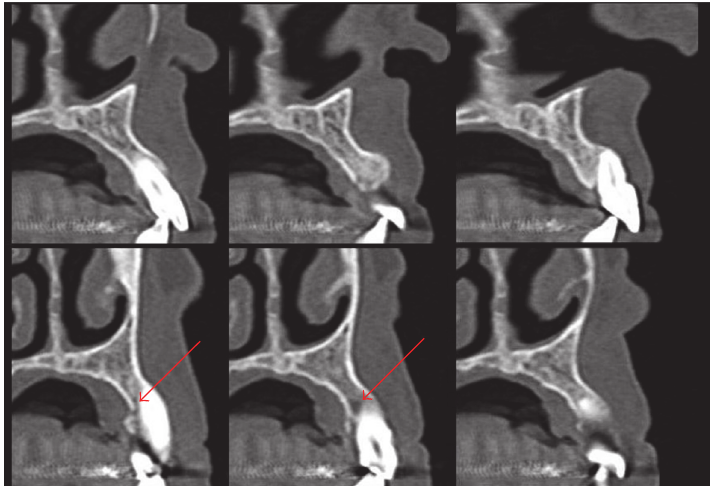
Figure 3: Preoperative CT. The red arrows point to the small depression of the bone surface in correspondence of the tumour (“cupping” or “saucerization”).